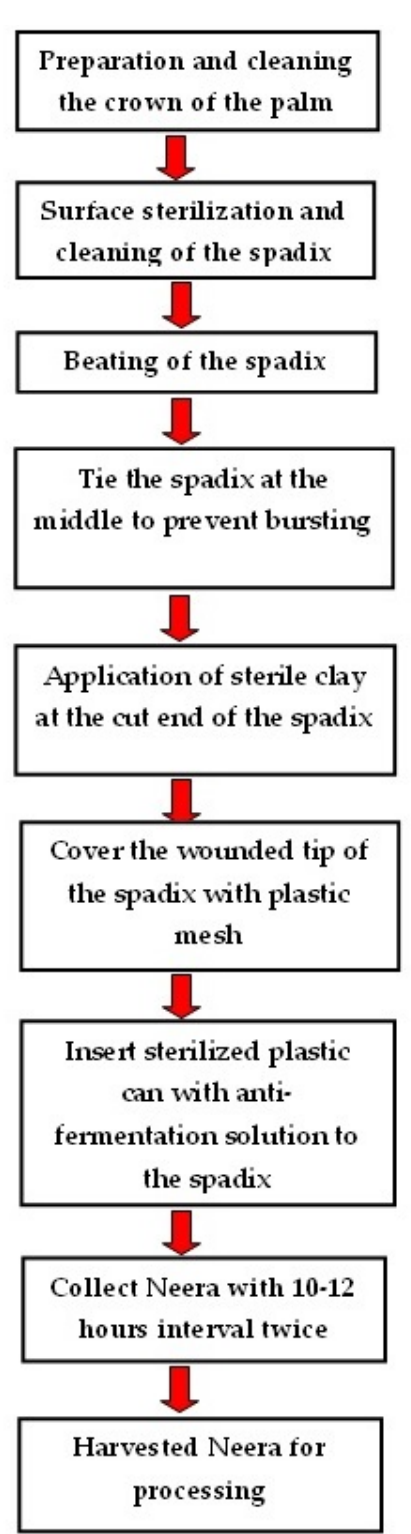
Figure 2. The modified harvesting steps of coconut Neera.